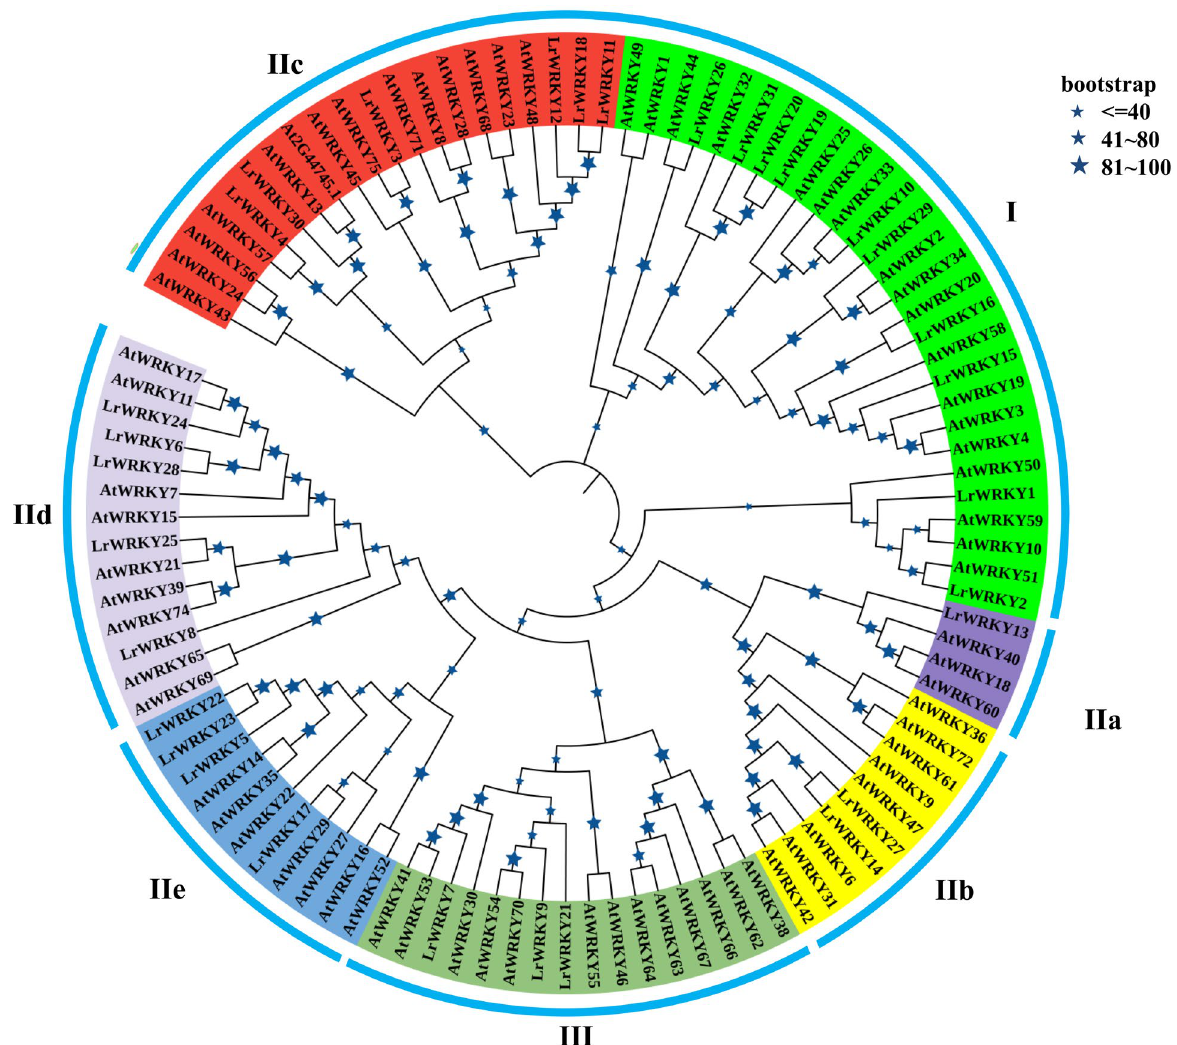
Figure 1. The phylogenetic analysis of L. radiata WRKY proteins. The neighbor-joining method was utilized to generate the phylogenetic tree relying on the WRKY domains alignment. These numbers are computed using 1000 bootstrap replicates to verify reliability. The replicate tree percentages indicated with different sizes of asterisk are presented on branches. The tree shows the three subfamilies marked with blue font on a colored background.